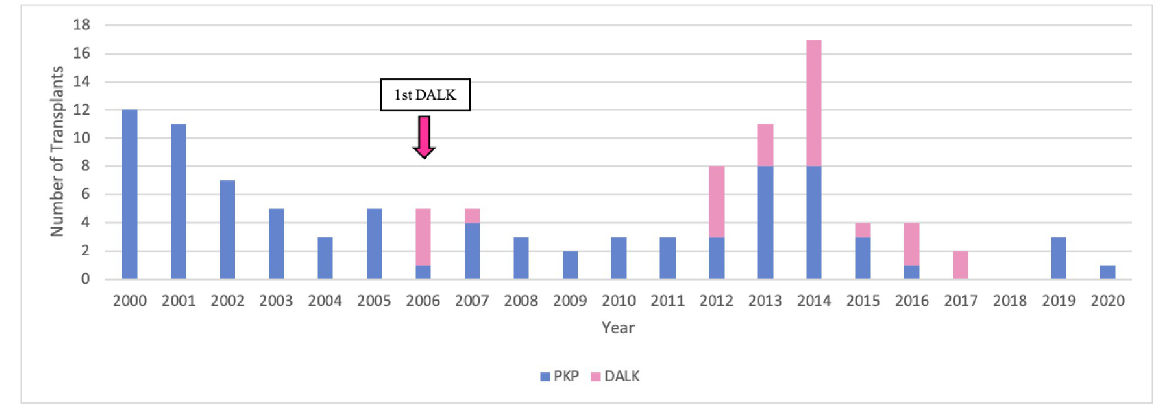
Fig 5. Changes over time in the type of surgery used for keratoconus. DALK, deep anterior lamellar keratoplasty; PKP, penetrating keratoplasty.